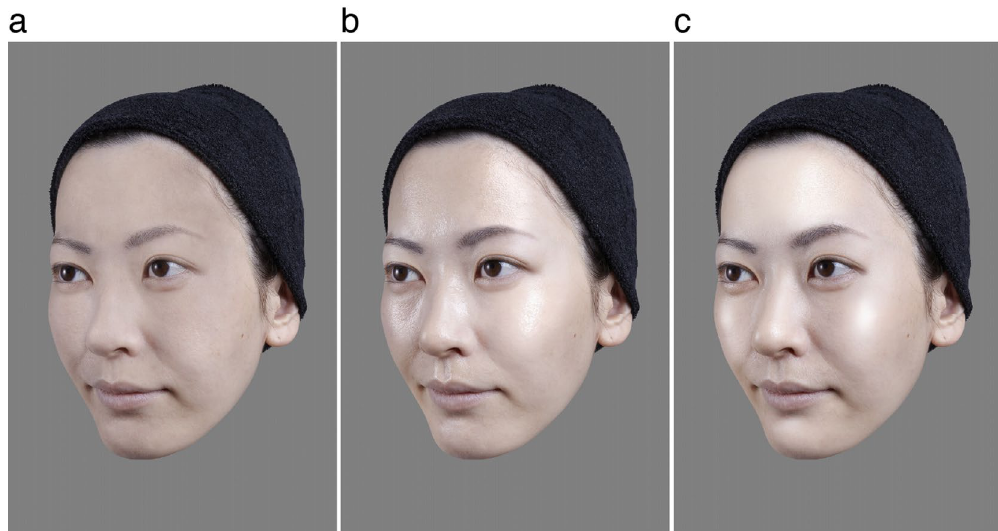
Figure 1. Examples of stimuli used in both fMRI and psychological experiments. The facial skin was matte (a) , oily-shiny (b) , or radiant (c)